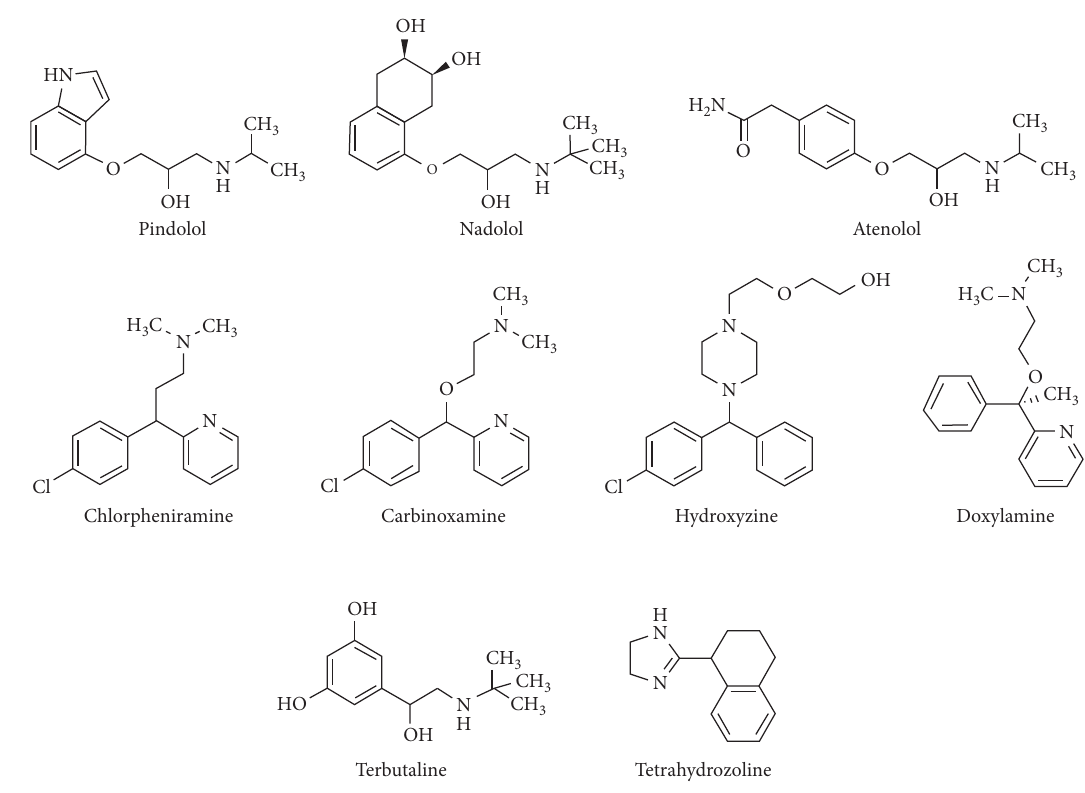
Figure 10: Chemical structure of basic nitrogen-containing compounds.